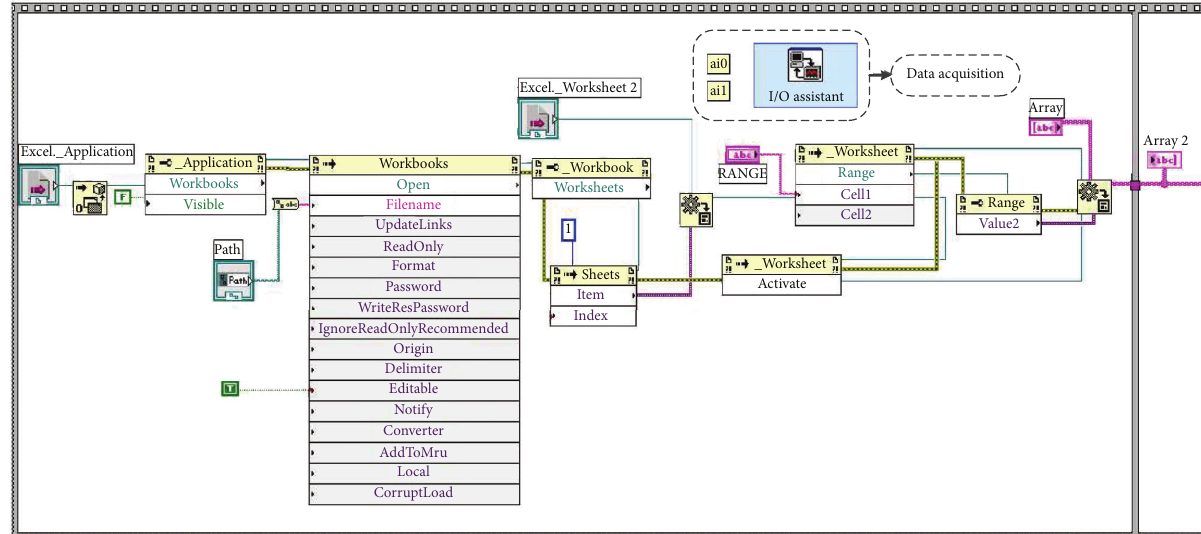
Figure 2: Labview code of signal acquisition and data storage.